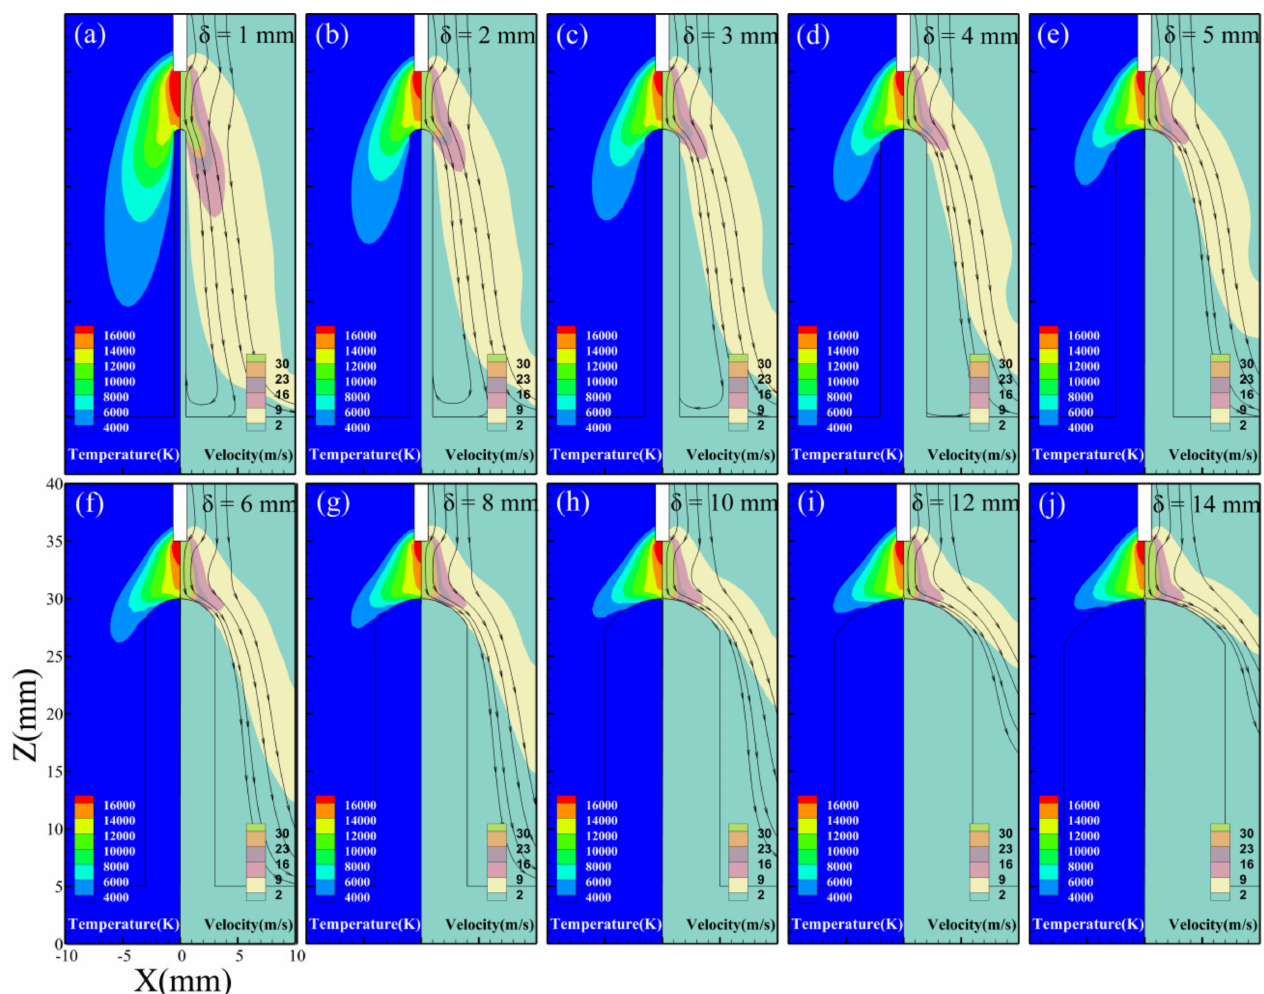
Figure 2. The temperature and velocity field of the arc on the XOZ plane: ( a ) δ = 1 mm, ( b ) δ = 2 mm, ( c ) δ = 3 mm, ( d ) δ = 4 mm, ( e ) δ = 5 mm, ( f ) δ = 6 mm, ( g ) δ = 8 mm, ( h ) δ = 10 mm, ( i ) δ = 12 mm, and ( j ) δ = 14